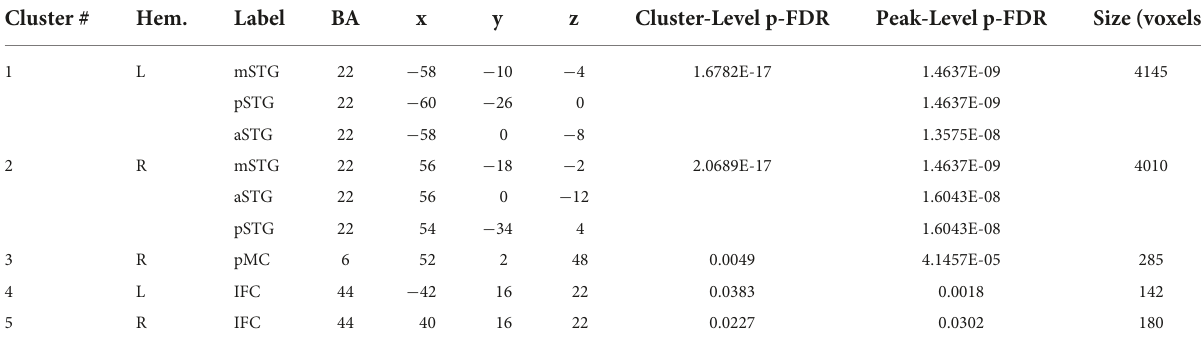
TABLE 1 Results from temporal voice area fMRI localizer